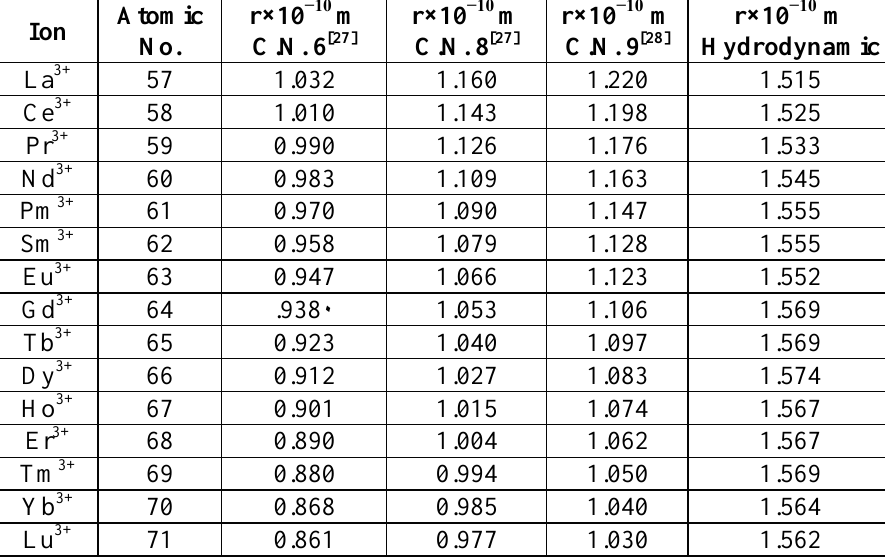
Table 2: Ionic and hydrodynamic radiuses of lanthanide